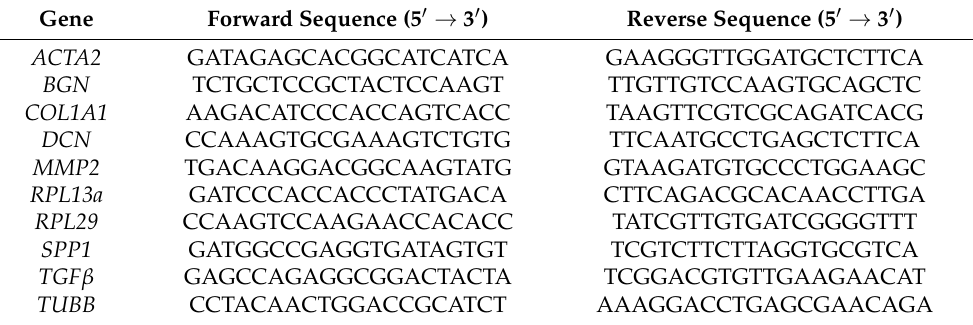
Table 1. Primer sequences used for gene expression